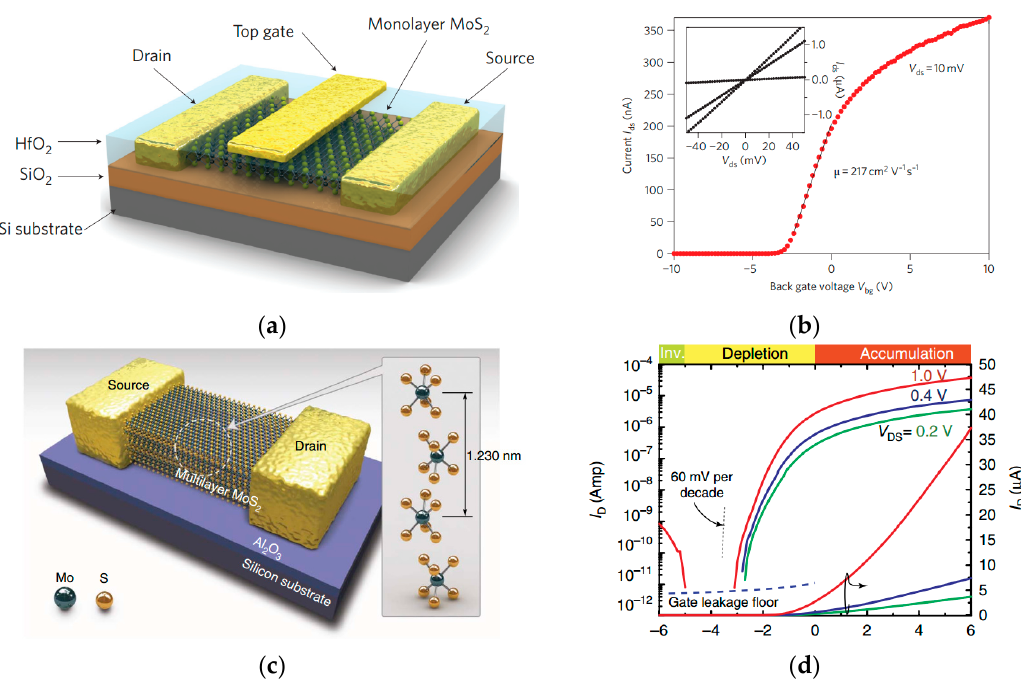
Figure 6. Schematics and performance of monolayer and multilayer MoS 2 transistors. ( a ) Schematic of MoS 2 monolayer transistors; ( b ) Room-temperature transfer characteristic for an FET with a 10 mV applied bias voltage V ds . Inset: I ds –V ds curve acquired for V bg values of 0, 1 and 5 V (Branimir Radisavljevic et al. [9]); ( c ) Schematic of a MoS 2 thin film transistors with a multilayer MoS 2 crystal; ( d ) Drain current versus back gate voltage, showing a ~10 6 on/off ratio and ~80 mV per decade subthreshold slope (Sunkook Kim et al. [75]).